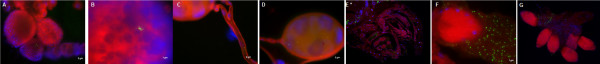
Dissemination of Rickettsia in flea tissues (7-14 days post-exposure). A-B: ovaries, C-D: salivary glands, E-G: rectal ampulla. * IFA on paraffin-embedded sections, otherwise on dissected tissues.